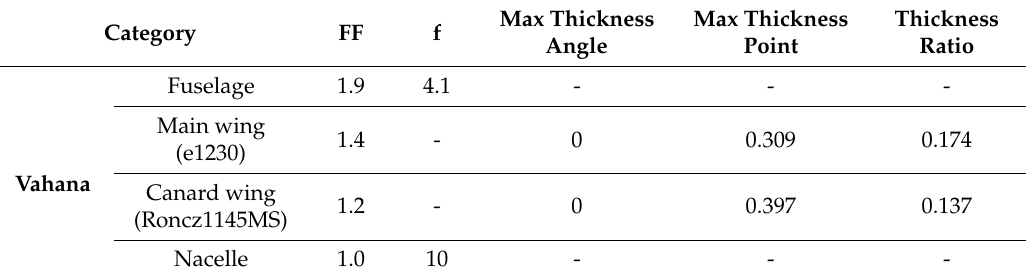
Table 7. Form factor of Vahana.